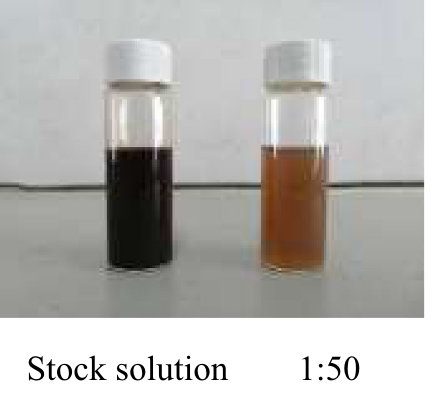
Figure 3. Appearance of Av-NDs.